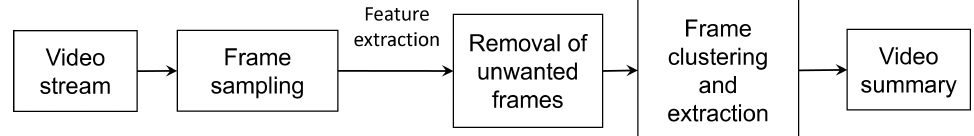
Figure 15. Flowchart for video